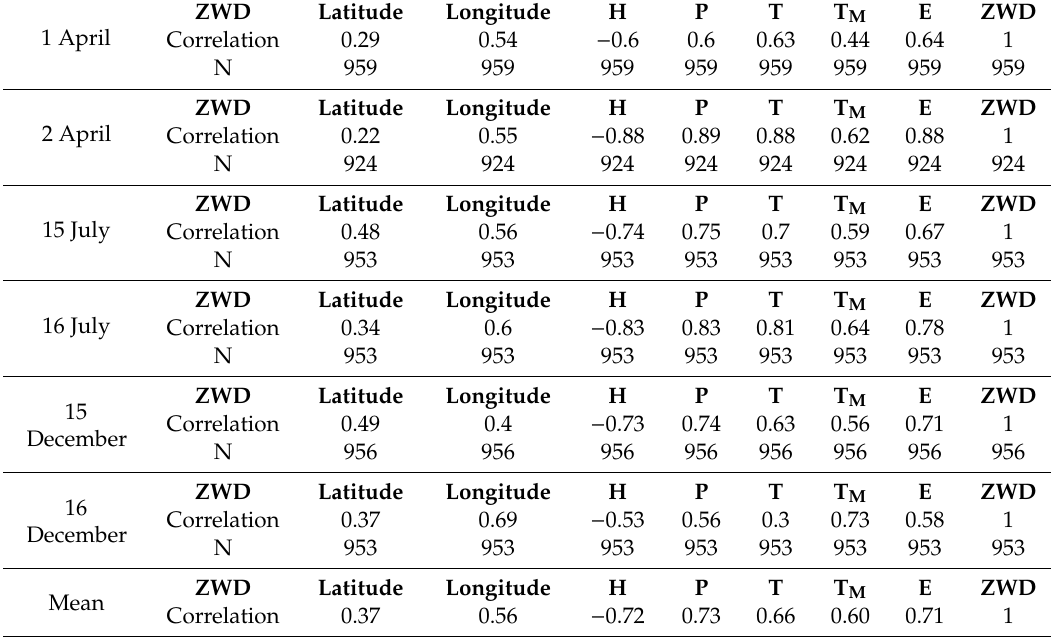
Table 1. Correlation coe ffi cients between meteorological parameters and zenith wet